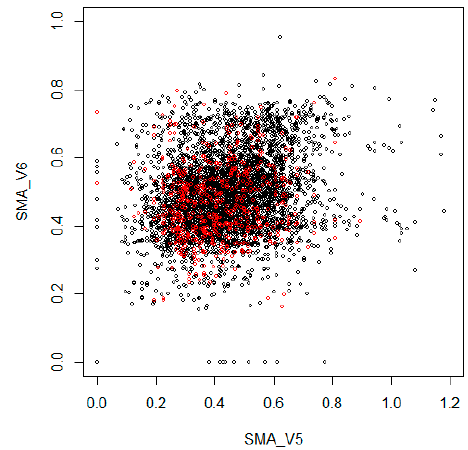
Figure A2. The scatter plot representing inconsistent surface moisture availability (SMA) values of the whole study area (black dot) and burned pixels of 2010 fires (red dot) derived from MOD16A2 Verison 5 (V5) and Version 6 (V6) with good quality.